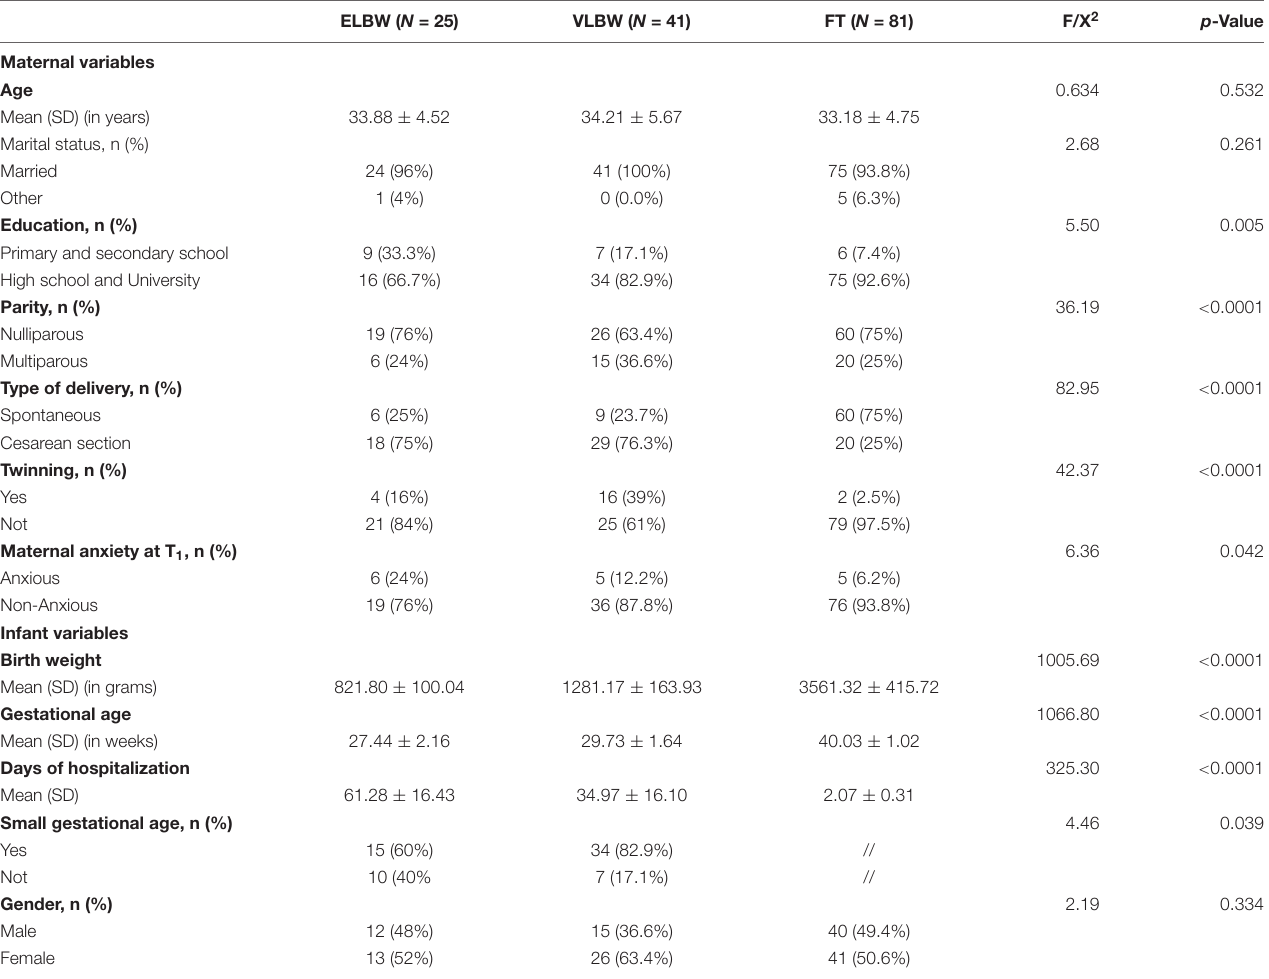
TABLE 1 | Dyads’ characteristics according to birth